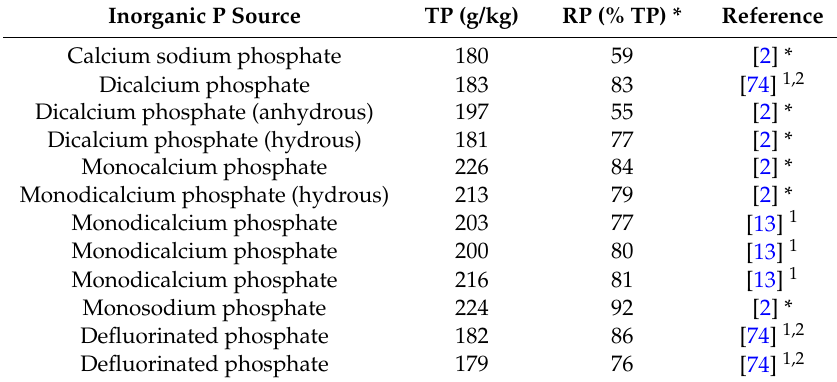
Table 5. Inorganic feed phosphates and their respective total P (TP) (g/kg) and retainable P (RP) (% of TP) [2]. Inorganic P Source TP (g/kg) RP (% TP) * Reference Calcium sodium phosphate 180 59 [2] * Dicalcium phosphate 183 83 [74] 1,2 Dicalcium phosphate (anhydrous) 197 55 [2] * Dicalcium phosphate (hydrous) 181 77 [2] * Monocalcium phosphate 226 84 [2] * Monodicalcium phosphate (hydrous) 213 79 [2] * Monodicalcium phosphate 203 77 [13] 1 Monodicalcium phosphate 200 80 [13] 1 Monodicalcium phosphate 216 81 [13] 1 Monosodium phosphate 224 92 [2] * Defluorinated phosphate 182 86 [74] 1,2 Defluorinated phosphate 179 76 [74] 1,2 * Values were determined in broilers fed diets containing 1.8 g calculated retainable P and 5.0 g Ca per kg diet from 10 days of age onward. P retention was measured in a three-day balance period (from days 21 to 24)